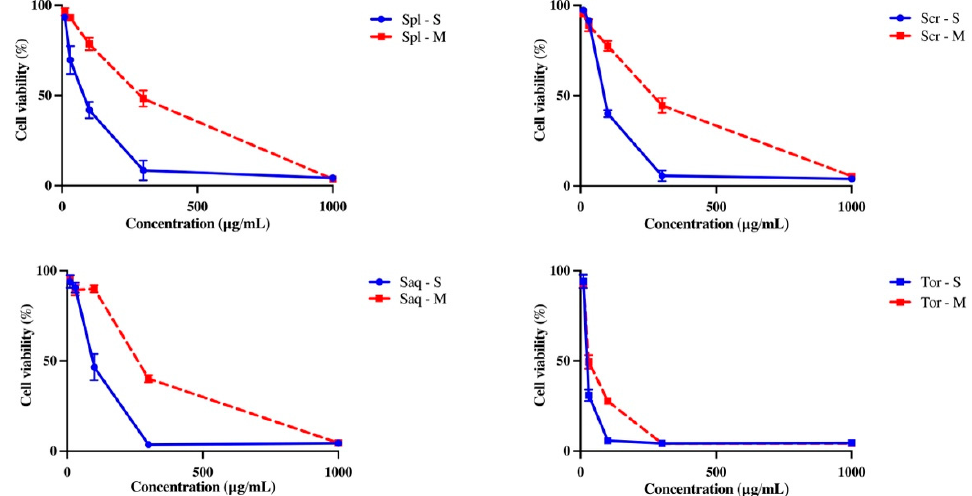
Figure 5. The effect of extraction techniques, cold maceration and ultrasonic-assisted extraction (UAE/sonication) on the cytotoxicity of Sargassum polycystum (Spl), Sargassum cristaefolium (Scr), Sargassum aquifolium (Saq) and Turbinaria ornata (Tor) towards the B16-F10 melanoma cell line observed with MTT assay. Results are expressed as mean ± SD. Table 2. IC 50 values of brown algae cold maceration and UAE (sonication) extract towards the B16- F10 melanoma cell line observed with MTT assay.